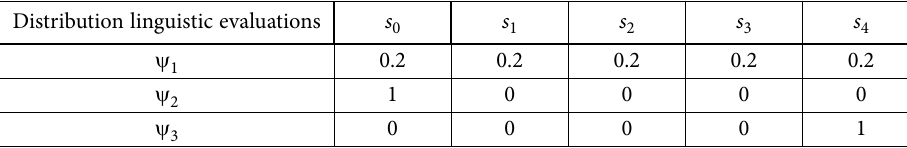
Table 1. Three distribution linguistic evaluations Distribution linguistic evaluations s 0 s